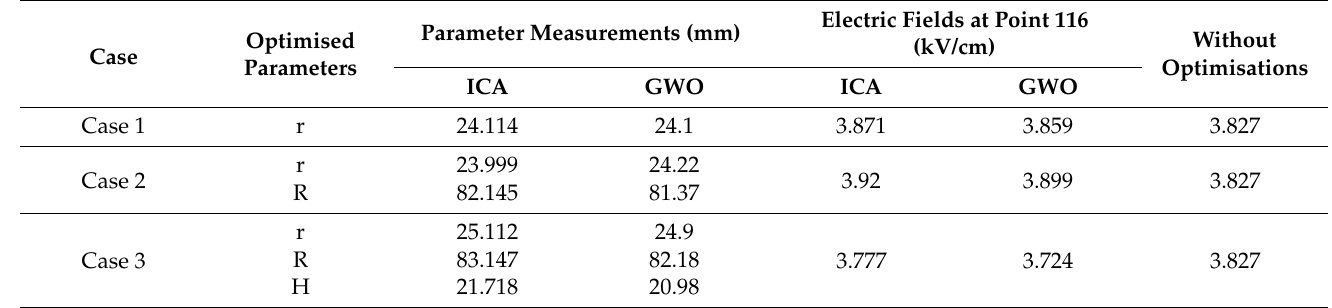
Table 7. Optimised parameters using ICA and GWO.